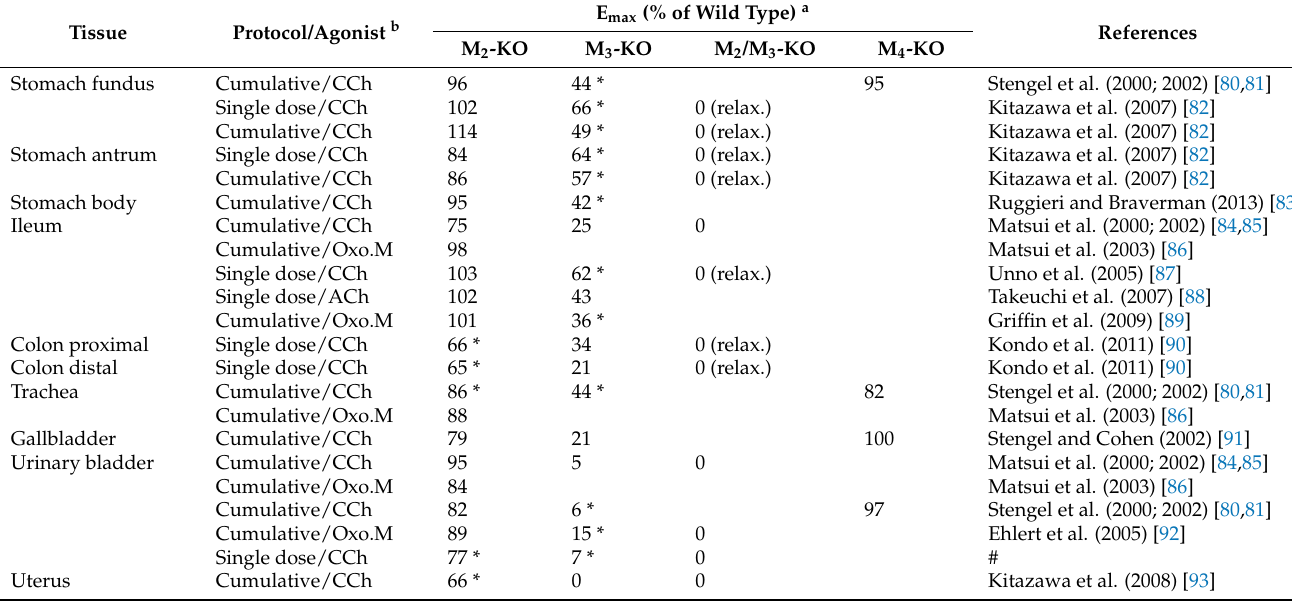
Table 1. E max values for muscarinic agonist-induced contraction of visceral smooth muscle from various mAChR- mutant